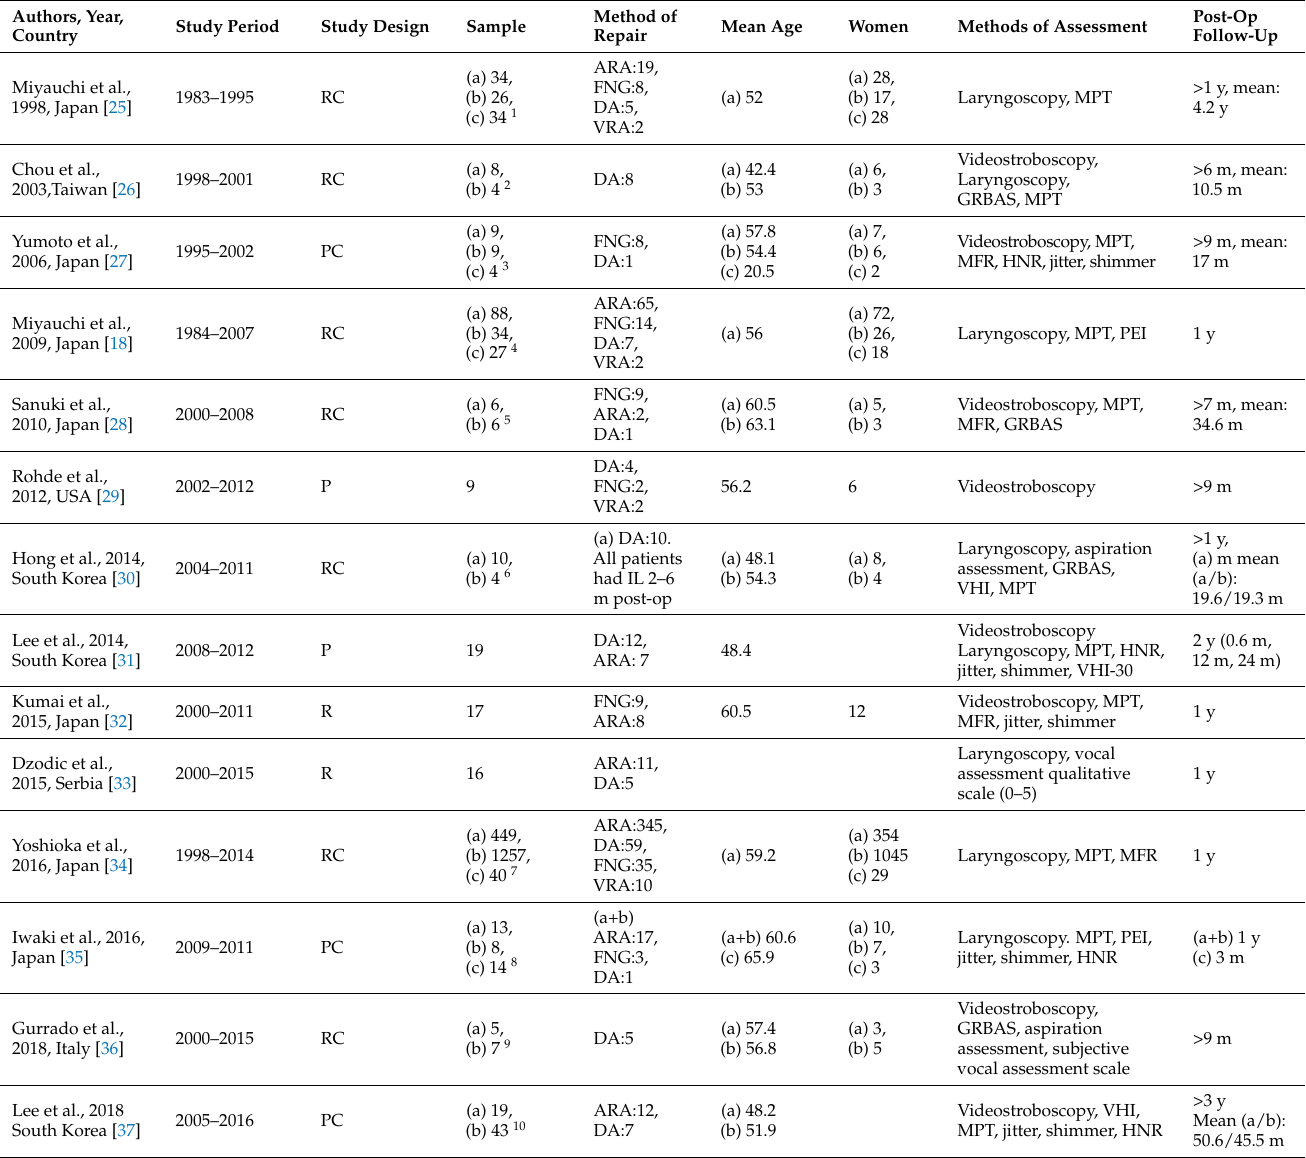
Table 3. General characteristics of the included